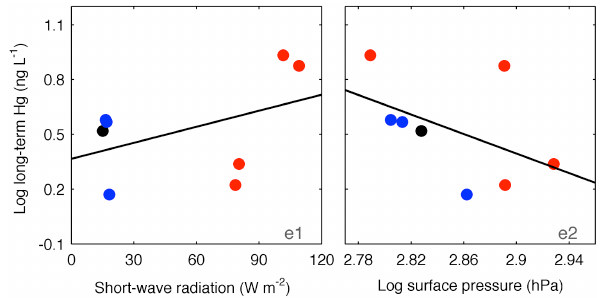
Fig. 7. Scatter plots of sufficiently strongly and significantly cor- related model environmental variables with Set2’s concentration of mercury in long-term snowpack-related records. Plotted as per Fig.